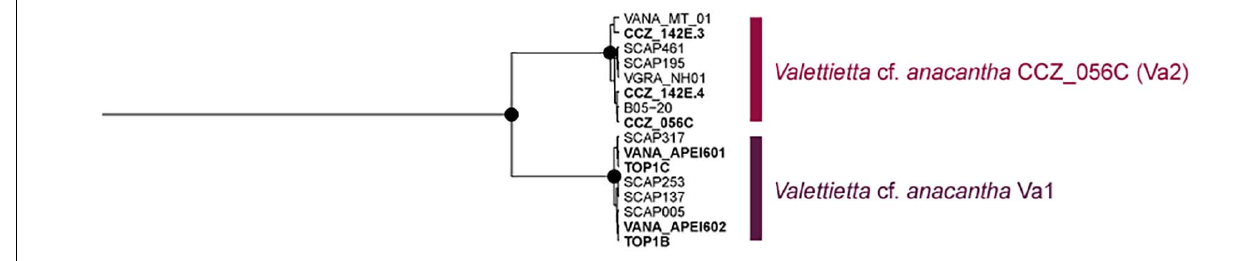
FIGURE 6 | Bayesian COI-only phylogenetic tree for the morphospecies Valettietta cf. anacantha . The two genetic clades are indicated on the right. Node posterior support values of 1.0 are indicated as black circles. Sequences generated in this study are highlighted in bold, with western CCZ labels starting with “CCZ_”.